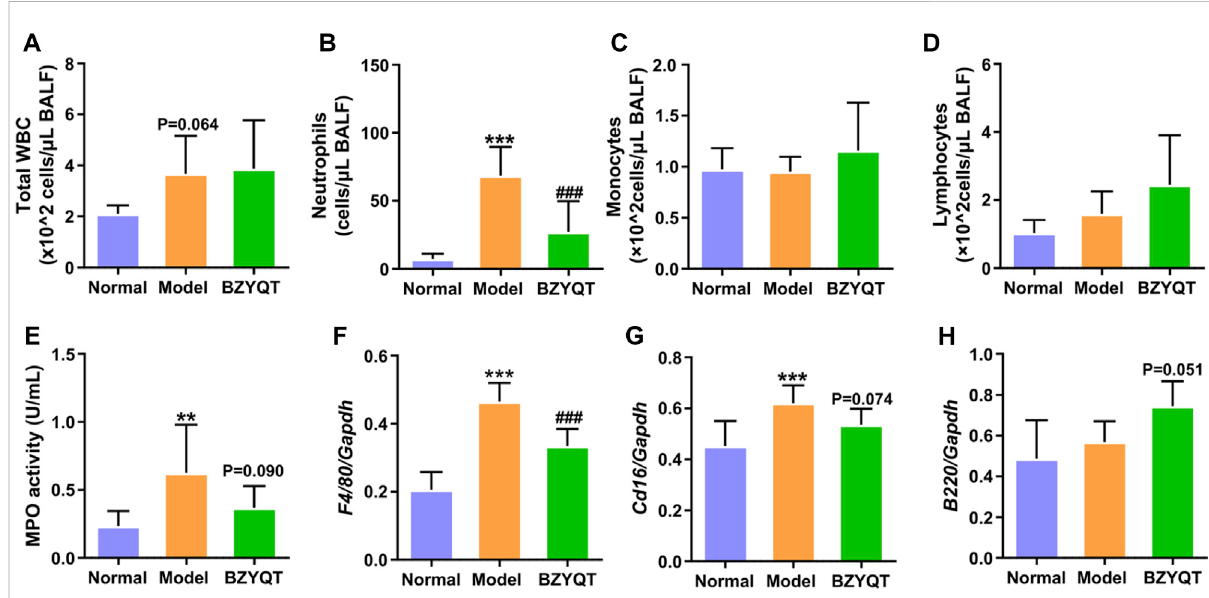
FIGURE 2 ImmunomodulatoryeffectsofBZYQTonthepulmonaryimmunecellin fi ltrationinducedbypoly(I:C).BZYQTwasprotectivelyadministeredfor 3 days ( n = 7 or 8). The number of (A) total WBCs, (B) neutrophils, (C) lymphocytes, and (D) monocytes in the BALF; (E) MPO activity in the BALF; the mRNAexpressionof (F) Ptprc(B220) , (G) Adgre1 ( F4/80 ),and (H) Cd16